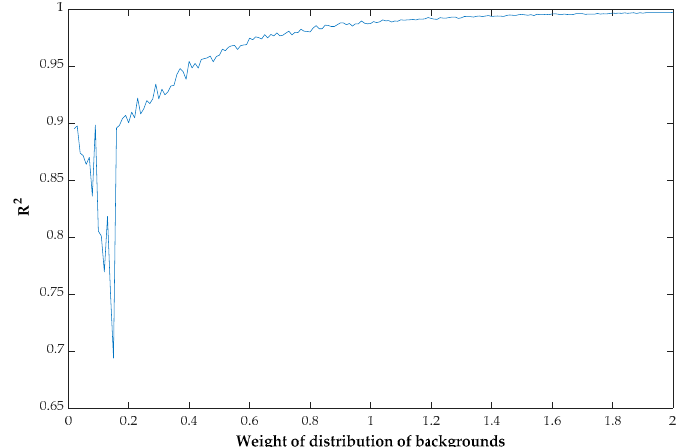
Figure 12. The coefficient of determination (R 2 ) curve changes with the weight of the distribution of backgrounds.